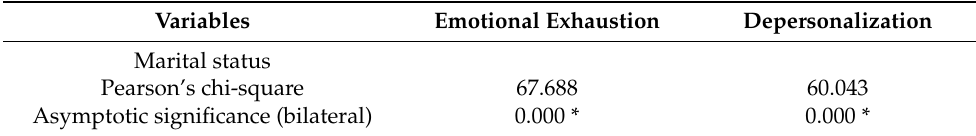
Table 2. Group statistics and Pearson’s chi-square test for marital status 1 .